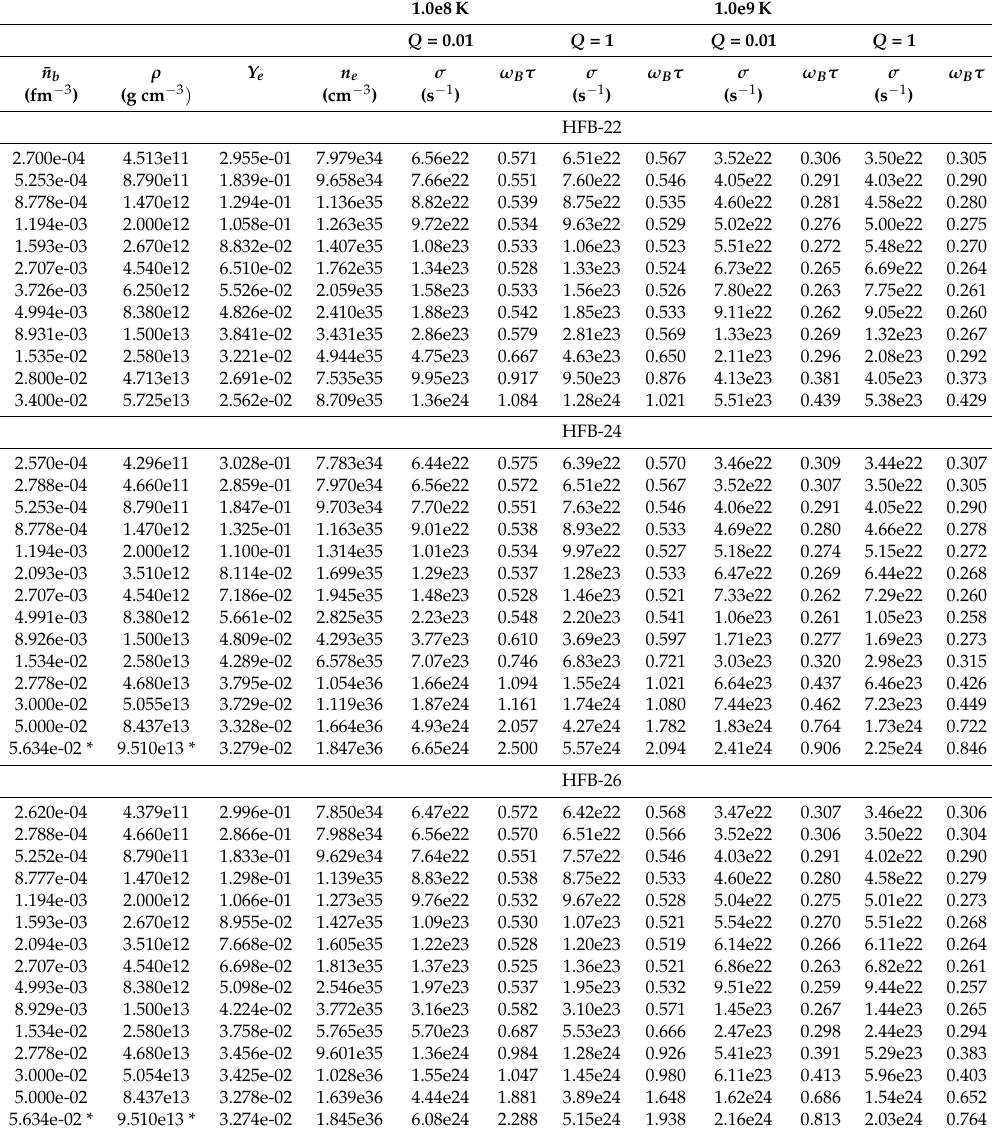
Table 2. Partial values of electrical conductivity and magnetization parameter for two different temperatures T and two different impurity parameters Q in the inner crust of NSs for the nuclear mass models HFB-22, HFB-24 and HFB-26. The unit of magnetization parameter ω B τ is the normalized magnetic field B 0 / ( 10 13 G ) when the dipolar magnetic field strength B 0 = 1.0 × 10 13 G. Here the crust is assumed to be isothermal.